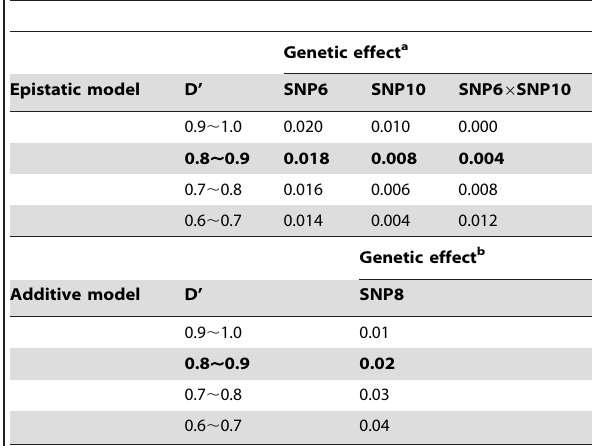
Table 2. Parameter configurations used in our simulation